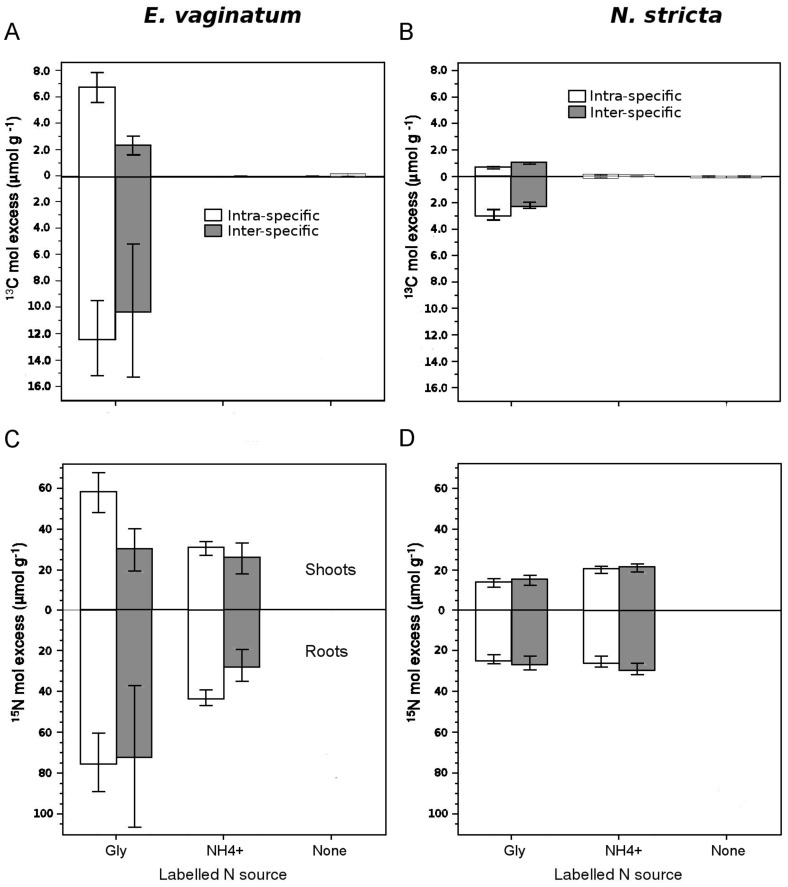
Plant competition and N sources uptake.Effects of competition on E. vaginatum and N. stricta
13C (a,b) and 15N (c,d) shoots (above the horizontal line on each plot) and roots (below the horizontal line on each plot) isotopic enrichment (expressed as molar excess) Data show plants grown experiencing intra- (C−) or inter-specific competition (C+) after applying N sources based on: glycine-ammonium solutions with isotopic dual-labelled (13C and 15N) glycine = Gly, 15N-labelled NH4
+ = NH4
+ or both compounds unlabelled = None. Values are means ±1 s.e. Note that whereas E. vaginatum molar excess is higher than that of. N. stricta, molar excess is expressed on a per plant biomass basis which was much lower for E. vaginatum (i.e., molar excess per se is not an indicator of competitive ability).